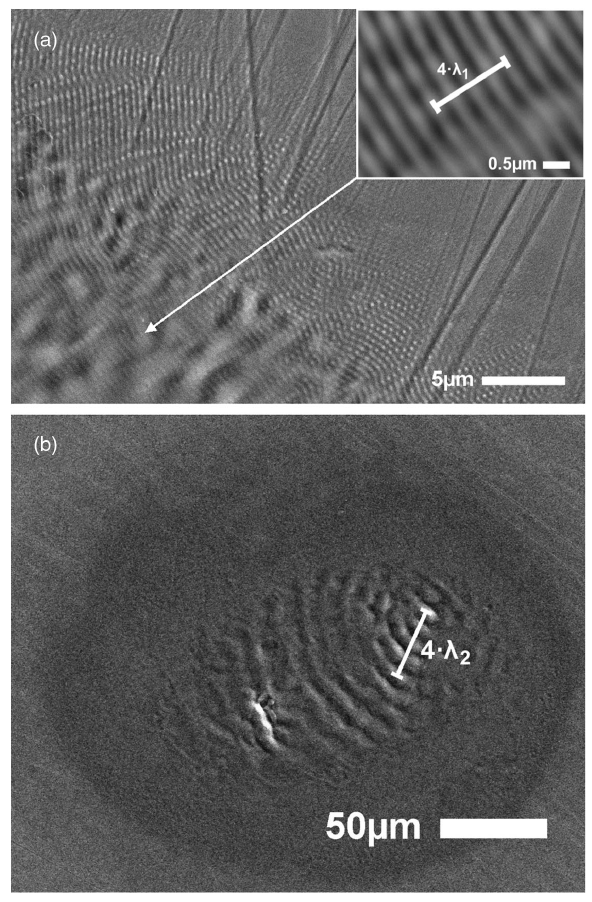
FIG. 3. SEM micrographs of the two characteristic types of waves propagating in the liquid phase with λ 1 ≈ 400 nm (a) ( F ¼ 0 . 68 J = cm 2 , N ¼ 180 ) and λ (b) ( F ¼ 1 . 4 J = cm 2 , N ¼ 80